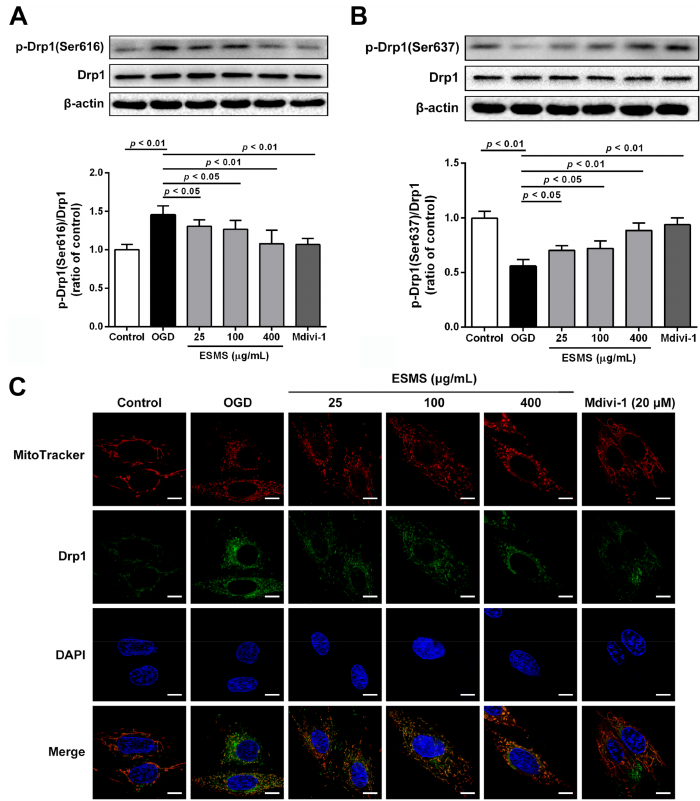
Figure 8. ESMS regulated Drp1 phosphorylation, translocation in H9c2 cells subjected to OGD. ( A ) Drp1 and p-Drp1 (Ser616) proteins expression levels were determined using Western blot analysis ( n =